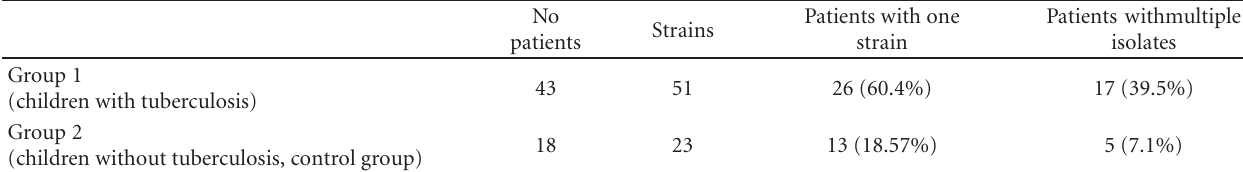
Table 1: Strains of H. influenzae isolated from patients with tuberculosis (Group 1) and children without tuberculosis (Gorup